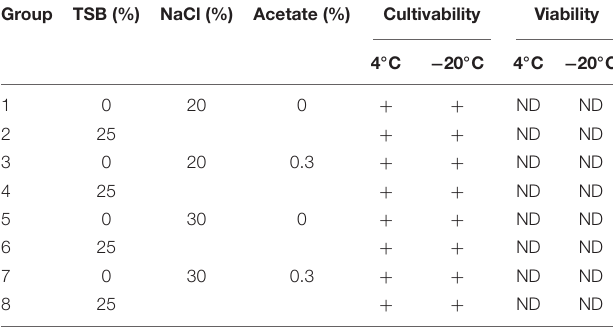
TABLE 7 | Inhibition of nutritional status in the formation of VBNC state of